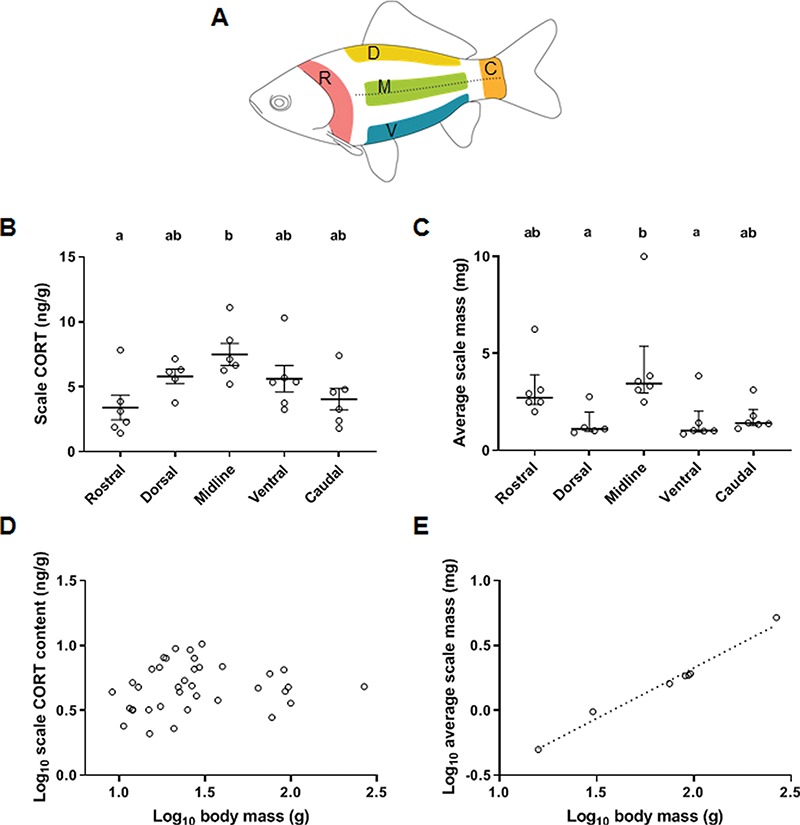
Spatial heterogeneity of scale cortisol (CORT) content. (A) Scales from five different body regions were analysed for cortisol content: R, rostral; D, dorsal; M, midline; V, ventral; C, caudal. (B) Regional cortisol content. Letters above regions show the output of Tukey’s post-test. Data are mean ± SEM. (C) Average scale mass across body regions. Letters above regions show the output of Dunn’s post-test on ranked data. Data are the median and interquartile range. Sample size is 6 per location, except for dorsal scales (n = 5). (D) Relationship between body mass and scale cortisol content. (E) Relationship between body mass and average scale mass